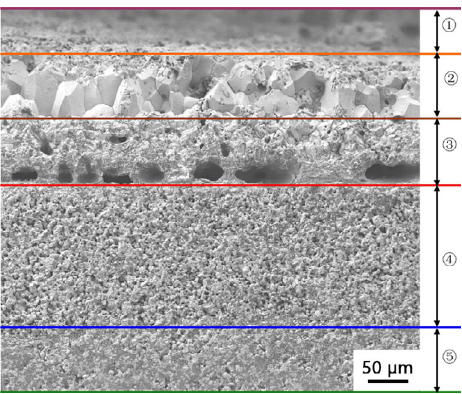
Fig. 13 Cross-section of ZrB 2 –SiC after oxidation at 2200 ℃ for 10 min. Reproduced with permission from Ref. [175], © Elsevier Ltd.